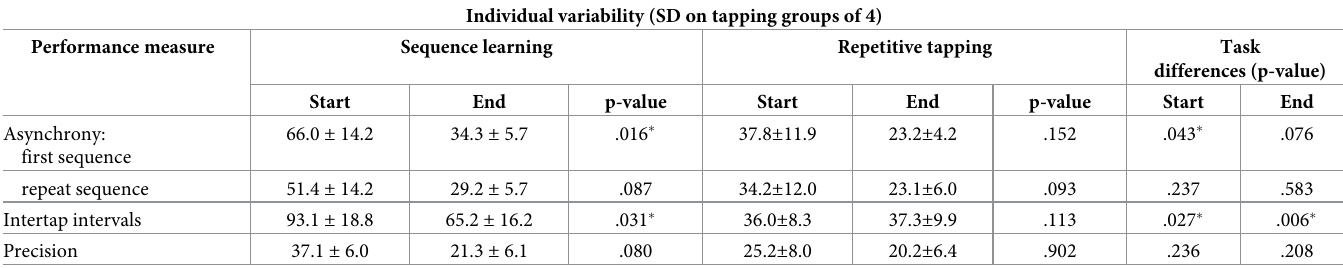
Table 2. Individual variability during sequence learning and repetitive